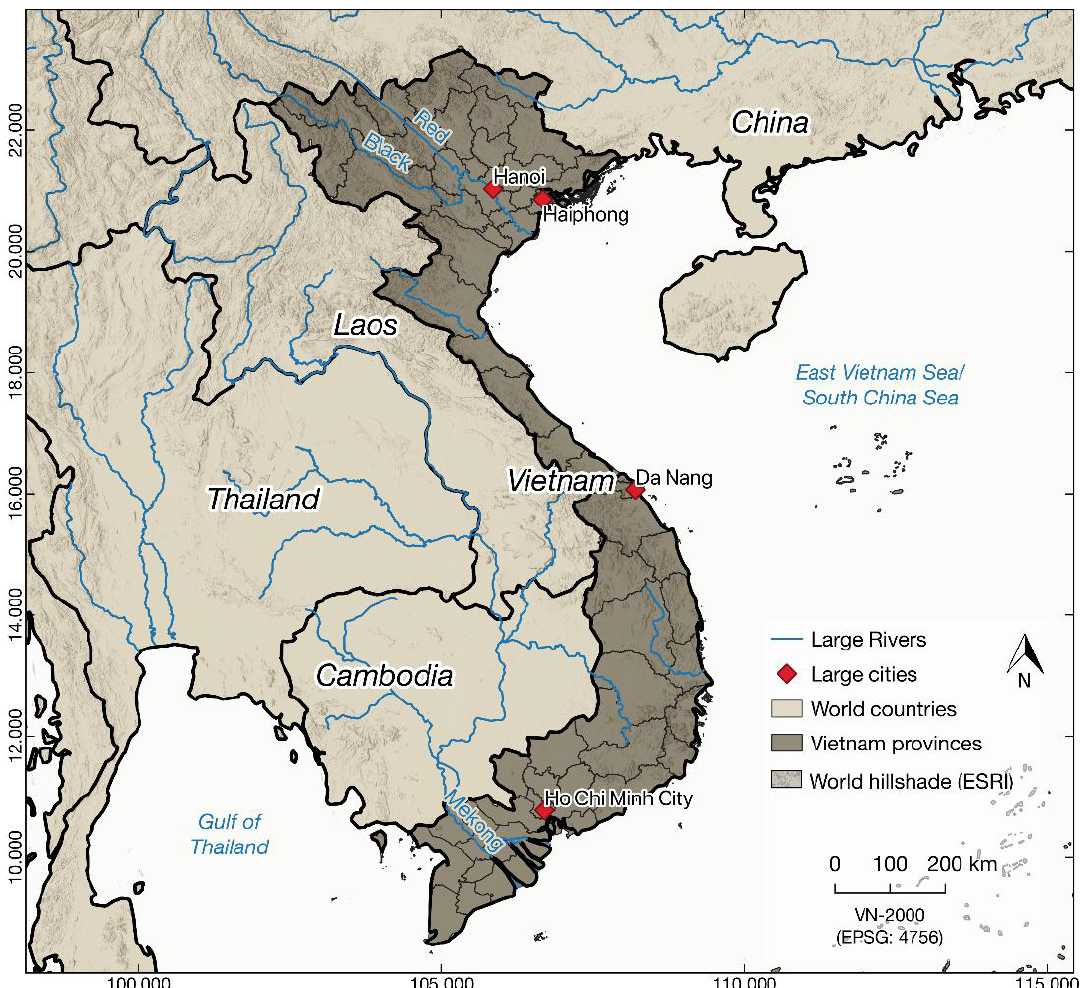
Figure 1. Study area: Vietnam.